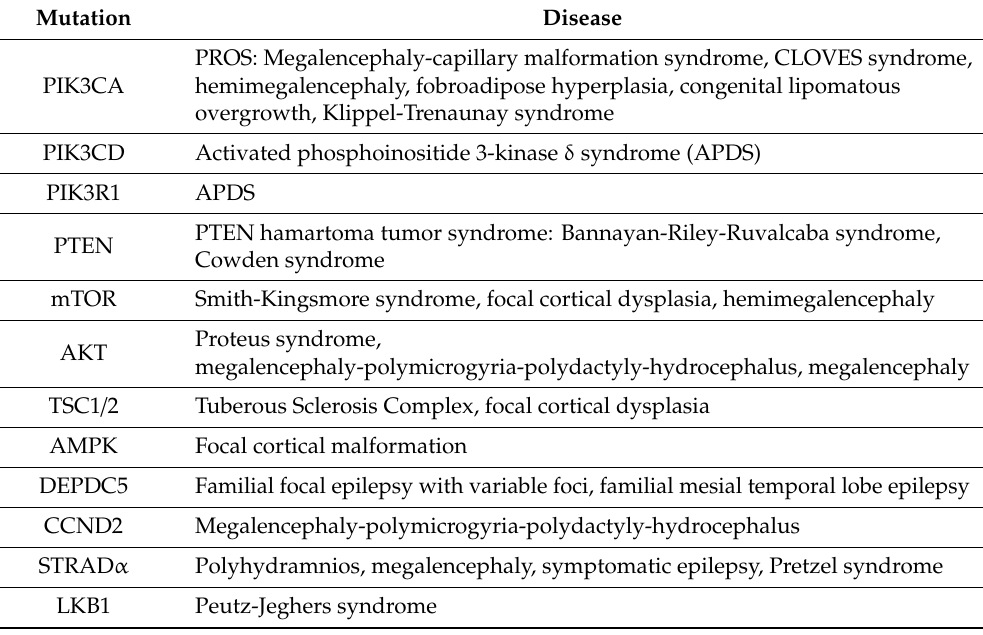
Table 1. Gene mutations of the PI3K / mTOR signaling pathway and associated genetic syndromes.